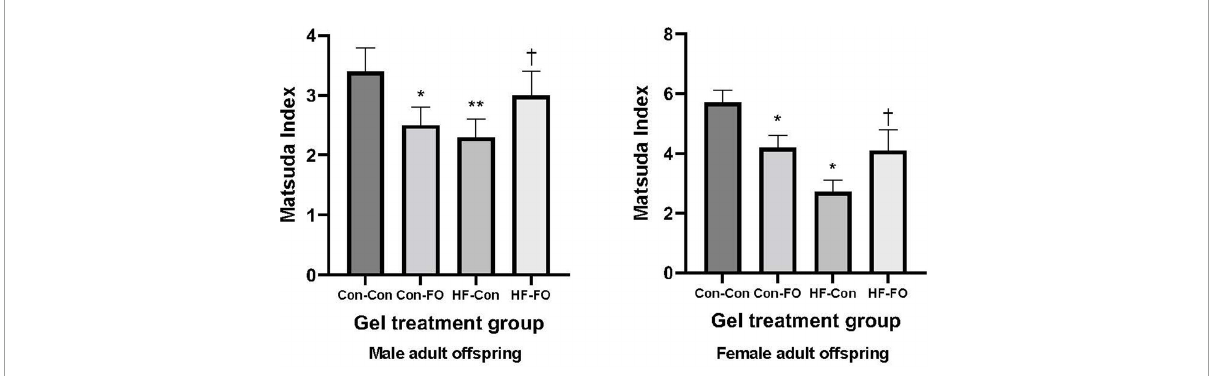
FIGURE3 Insulin sensitivity derived by Matsuda Index in the male and female adult offspring (day 95) presented according to the maternal diet (control or high-fat diet) and the gel treatment during pregnancy [Fish oil or control (no oil gel)]. Data are Means (SE). * p < 0.05; ** p < 0.005 vs. con-con † p < 0.05 vs. HF-Con.